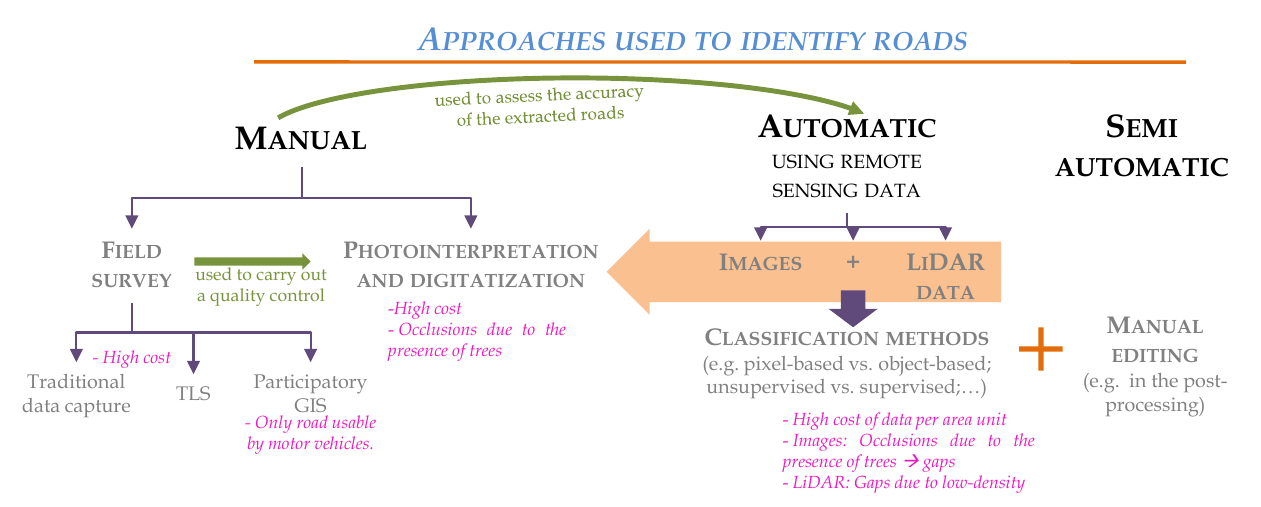
Figure 1. Approaches used to identify